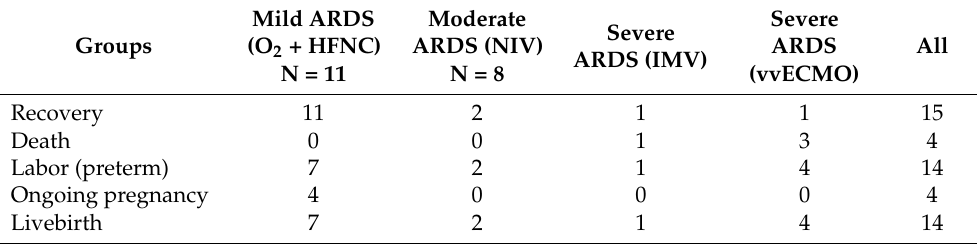
Table 1. Final maternal and neonatal outcomes in groups with different types of respiratory support